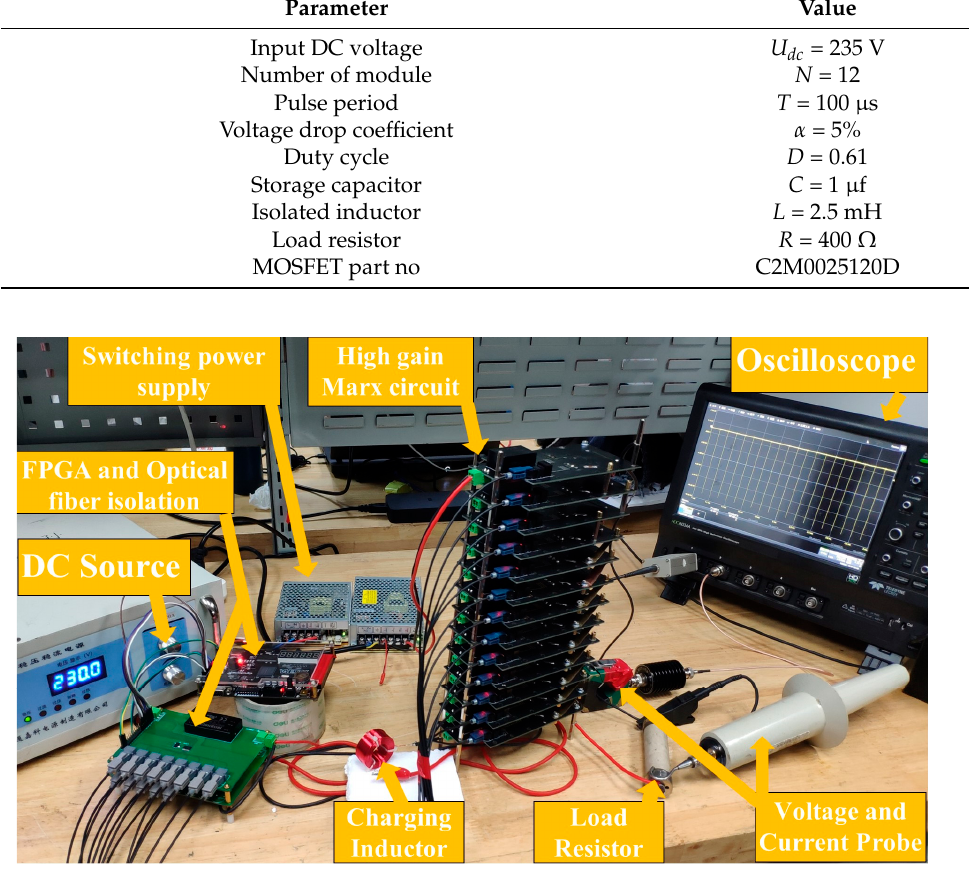
Table 3. Proposed topology experiment parameter for 10 kV pulse.